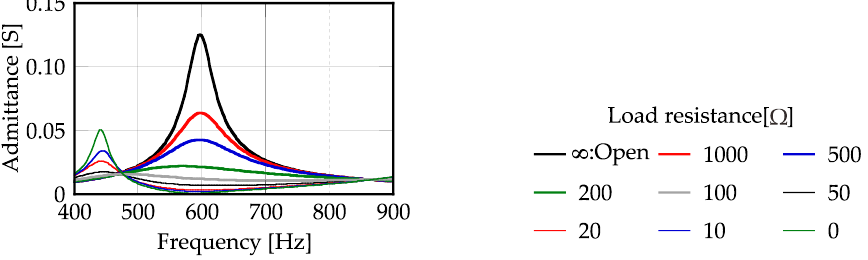
Figure 16. Frequency characteristics of combined electromagnets and capacitors. Dashed line represents the driving frequency (800 Hz). ( a ) Primary electromagnet. ( b ) Secondary electromagnet.